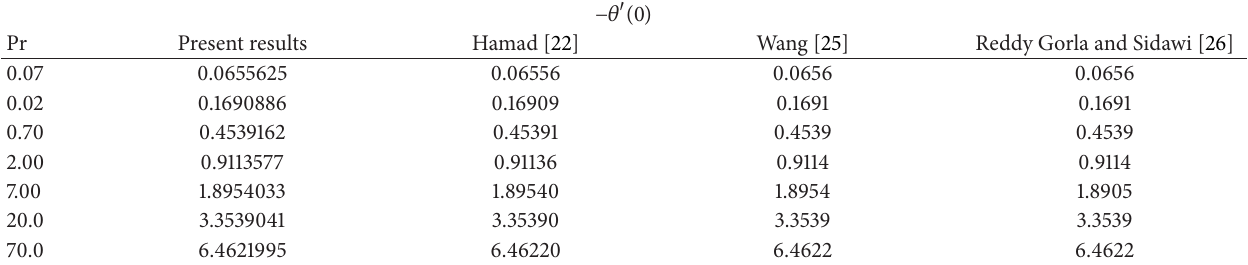
Table 2: Comparison of results for −𝜃 󸀠 (0) when 𝜙 = 0 , 𝑠 = 0 , and 𝛿 1 = 𝛿 2 = 0 .